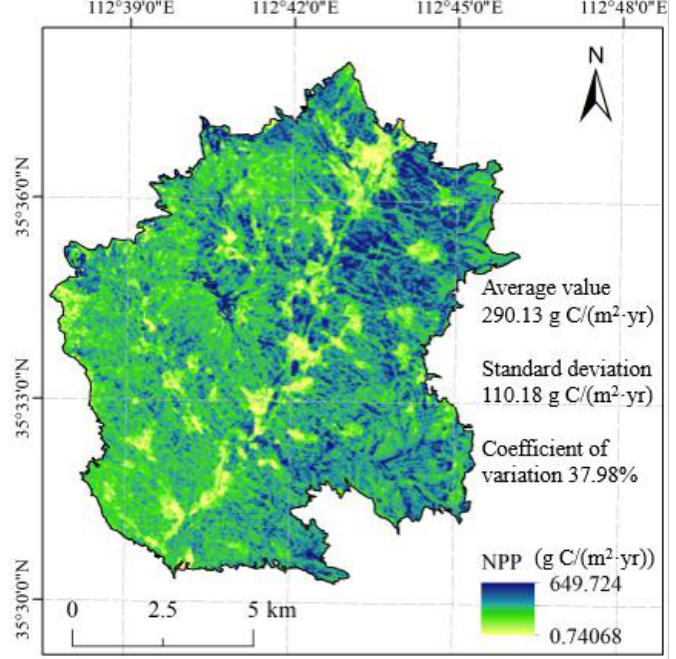
Figure 2. Spatial distribution map of annual mean net primary vegetation productivity from 2010 to 2015. Table 2. Simulated NPP, measured NPP and MOD17A3 for different land use types (g C/(m 2 ·yr)).